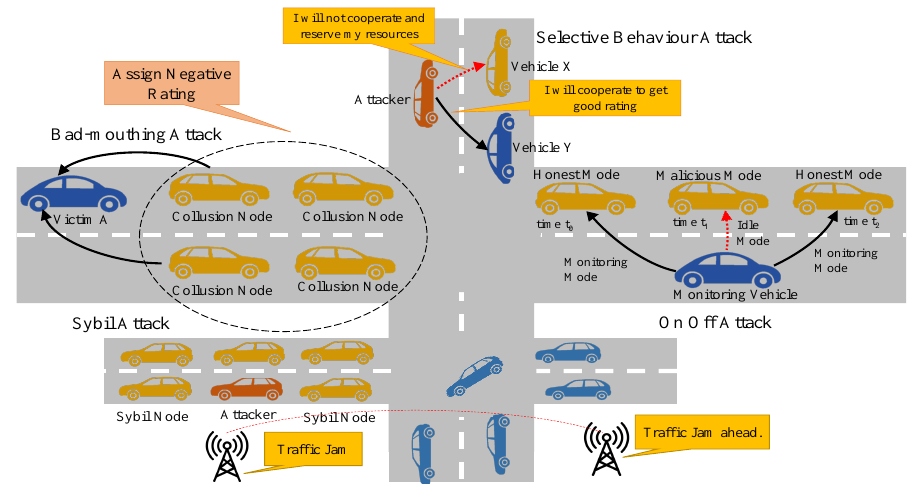
Figure 5. Attacks in the Internet of